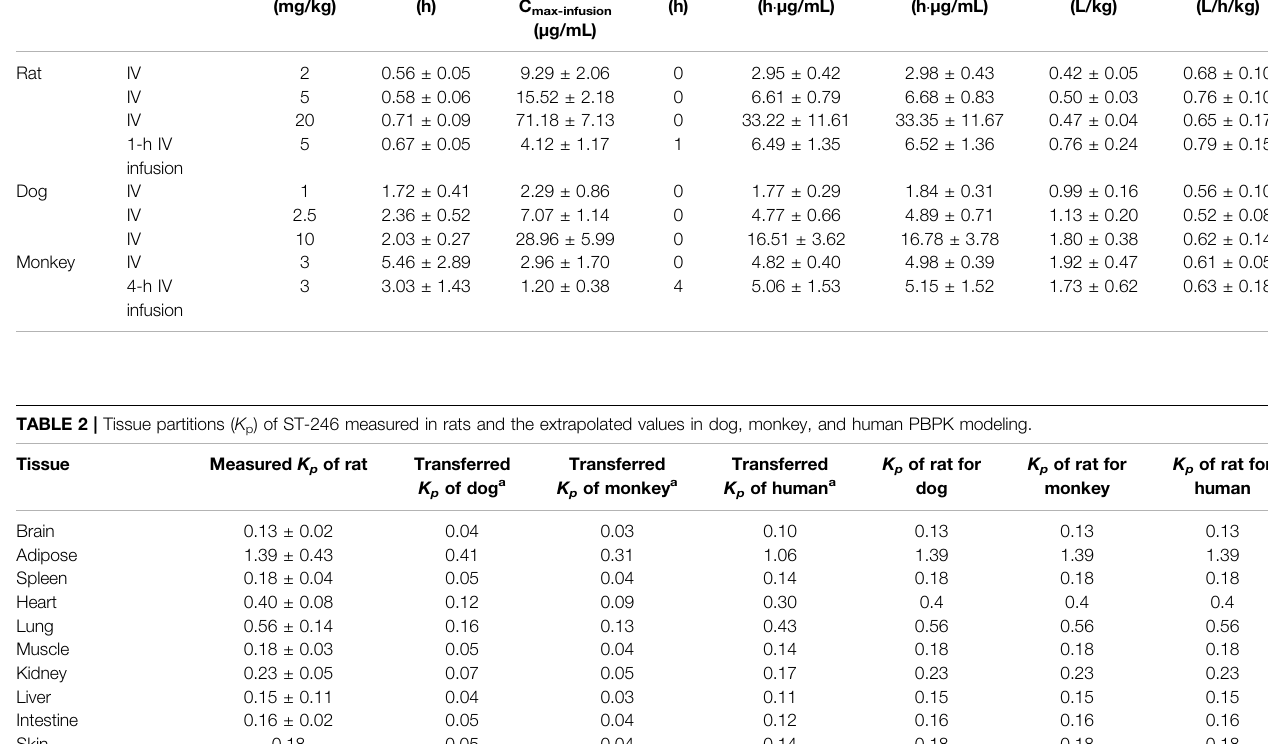
TABLE 1 | Comparison of pharmacokinetic parameters for ST-246 after IV administration to rats, dogs, and monkeys and IV infusion in rats and monkeys ( n = 6). Species Route